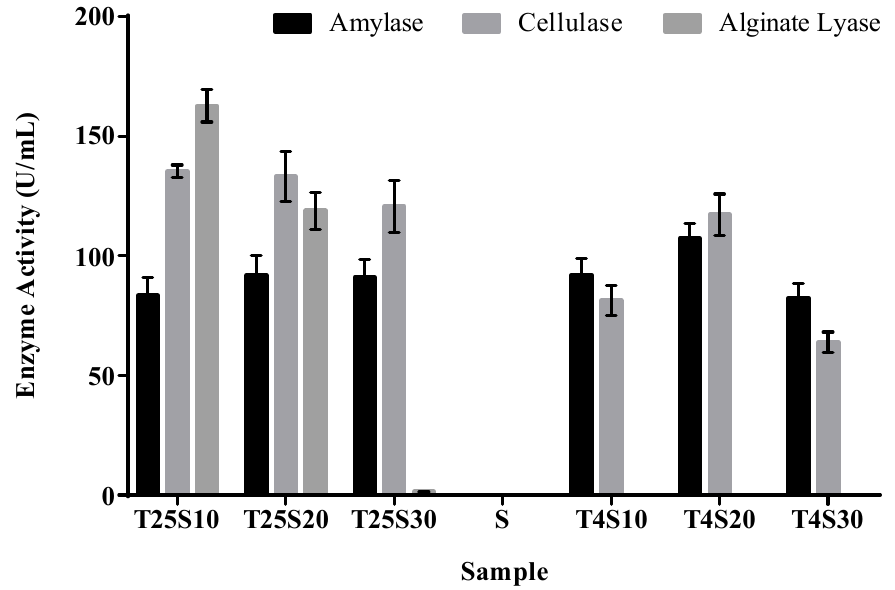
Figure 2. Enzyme activity determination results of amylase, cellulase, and alginate lyase in different treatment salted kelp samples .